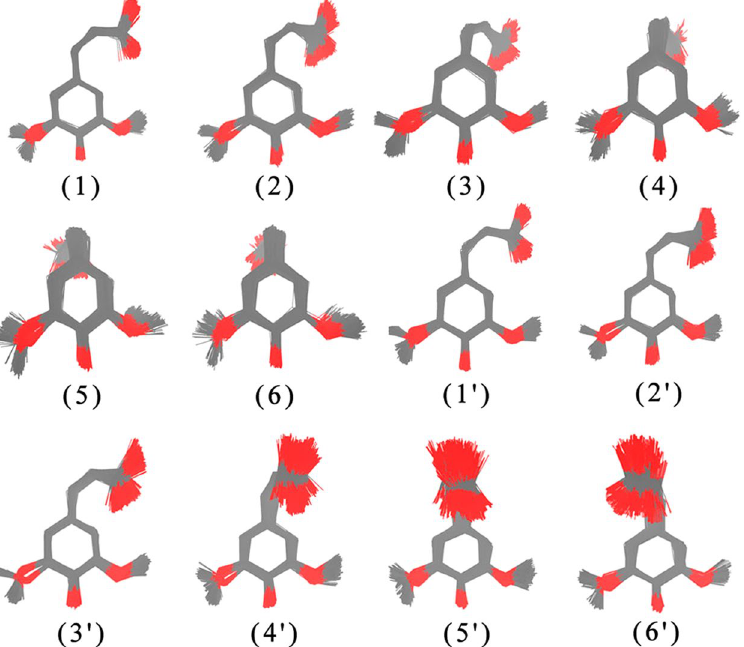
Figure 1. Possible meta-stable patterns derived from K-means clustering results. The oxygen and carbon atoms are shown in red and gray, and the position of the hydrogen atom is not shown for